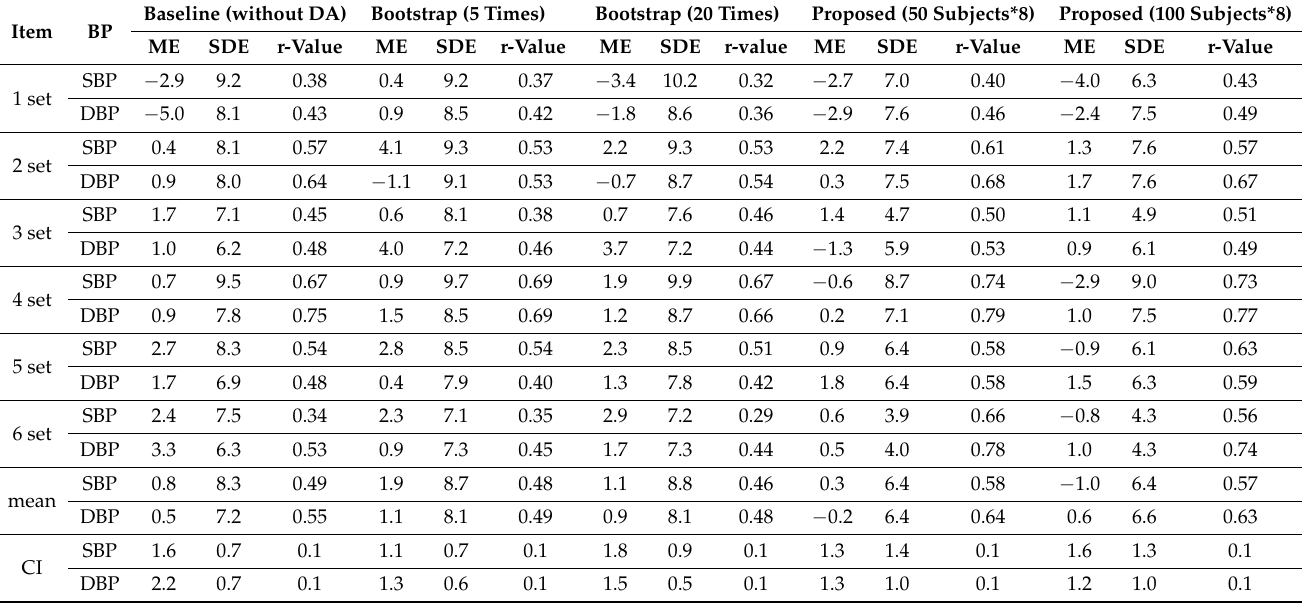
Table 3. Experimental results (unit: mmHg) of the proposed algorithm and bootstrap algorithm for estimating the BP using the stacked